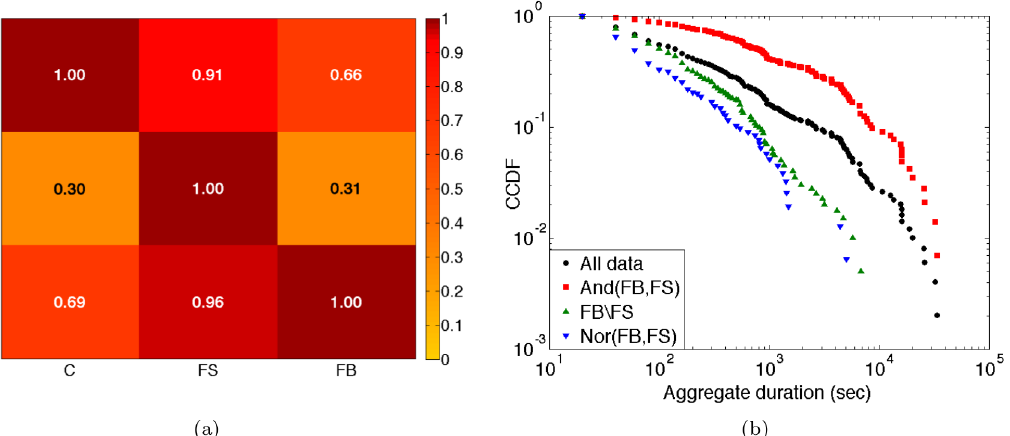
Fig 9. Multiplex Analysis. (a) Conditional probability to find a link in one layer (row index) given its existence in another one (column index); “ C ” stands for contact network, “ FS ” for friendship survey, “ FB ” for Facebook; (b) Distribution of aggregate durations in the contact network for different sets of